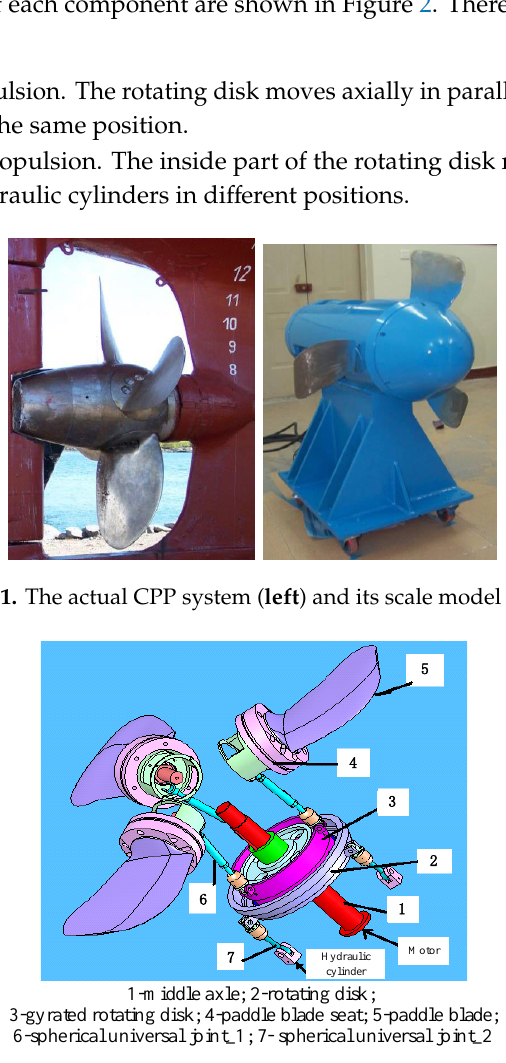
Figure 3. Block diagram of the CPP control system. 2.2. Modeling of the CPP System According to the block diagram of the CPP control system, the main equipment consists of the servo valve, hydraulic cylinder, grating ruler, and electrohydraulic servo amplifier. In the scale model of the CPP system, the servo valve is selected as a CSDY-I type jet pipe electro- hydraulic servo valve. The rated current of the servo valve is ±8 mA, and the rated pressure is 21 MPa. According to the manufacturer’s manual, the model of the servo valve can be expressed as [34]: